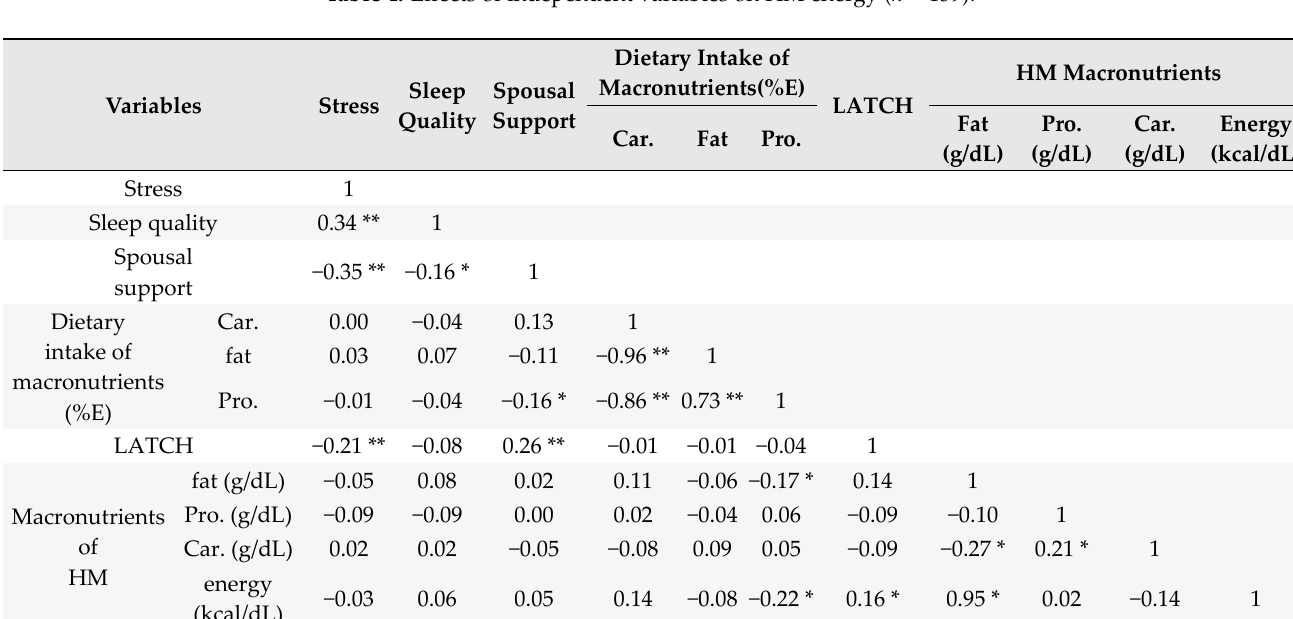
Table 4. Effects of independent variables on HM energy ( n = 159)